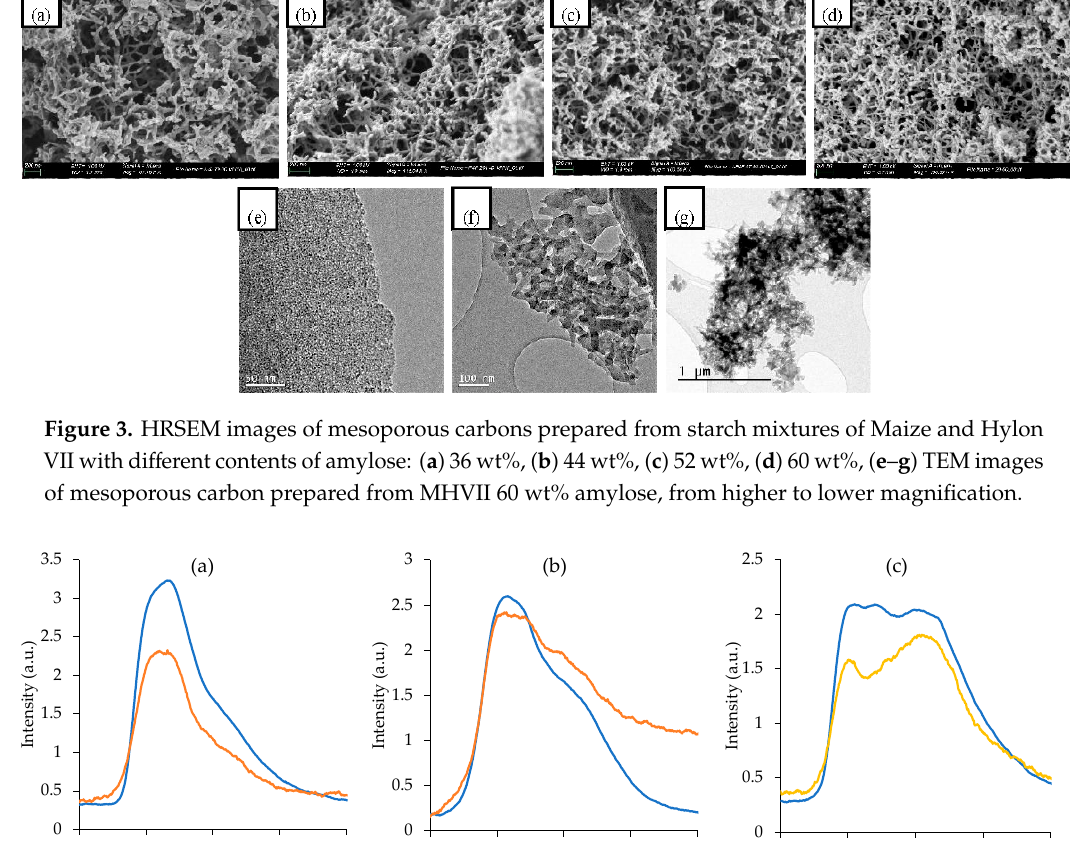
Figure 3. HRSEM images of mesoporous carbons prepared from starch mixtures of Maize and Hylon VII with different contents of amylose: ( a ) 36 wt%, ( b ) 44 wt%, ( c ) 52 wt%, ( d ) 60 wt%, ( e – g ) TEM images of mesoporous carbon prepared from MHVII 60 wt% amylose, from higher to lower magnification.